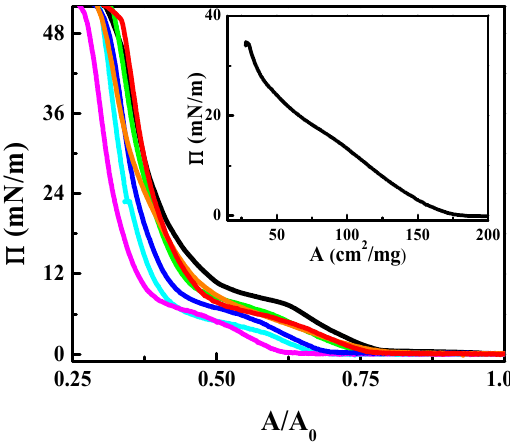
Figure 3. Π – A/A 0 isotherms for the Langmuir monolayer of 1,2-Dipalmitoyl-sn-glycerol-3- Figure 3. Π – A / A 0 isotherms for the Langmuir monolayer of 1,2-Dipalmitoyl-sn-glycerol-3-phosphocholine phosphocholine (DPPC) containing different amounts of CN. Each curve corresponds to DPPC (DPPC) containing di ff erent amounts of CN. Each curve corresponds to DPPC monolayers with a monolayers with a different weight fraction of CN at the interface ( x c ): ( ― ) 0.00, ( ― ) 0.12, ( ― ) 0.26, di ff erent weight fraction of CN at the interface ( x c ): ( — ) 0.00, ( — ) 0.12, ( — ) 0.26, ( — ) 0.30, ( — ) 0.33, ( — ) ( ― ) 0.30, ( ― ) 0.33, ( ― ) 0.42 and ( ― ) 0.50. The inset represents the isotherm obtained for the CN 0.42 and ( — ) 0.50. The inset represents the isotherm obtained for the CN monolayer.